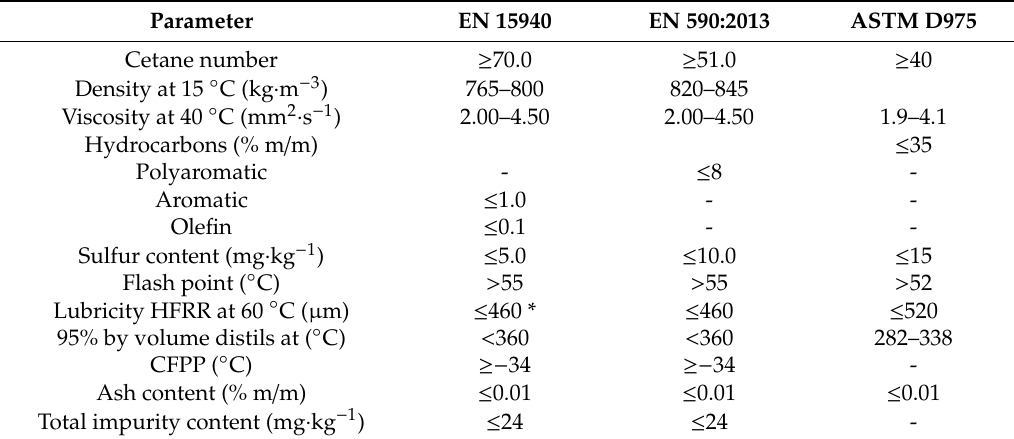
Table 1. Requirements of EN 15940, EN 590 and ASTM D975